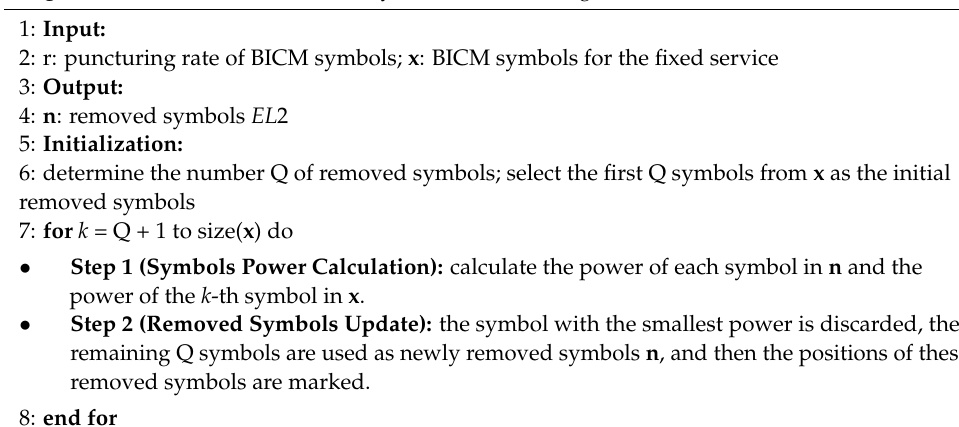
Figure 7. Comparison of the constellation of the LDM symbols with and without NEISP in the LDM-Ex-FDM scheme, where the injection level was set to ∆ = 0 dB, the CL constellation was set to quadrature phase-shift keying (QPSK), and the EL constellation was set to NU − 64QAM (non-uniform quadrature amplitude modulation): ( a ) LDM symbol constellation before puncturing; ( b ) LDM symbol constellation after puncturing. Algorithm 1 Selection of Removed Symbols in NEISP Algorithm.